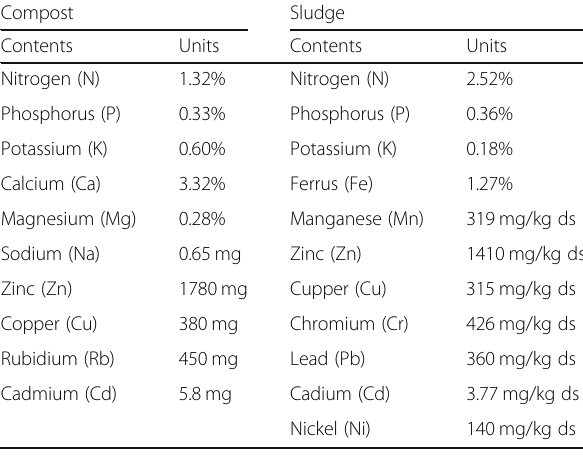
Table 2 Chemical compounds of compost and